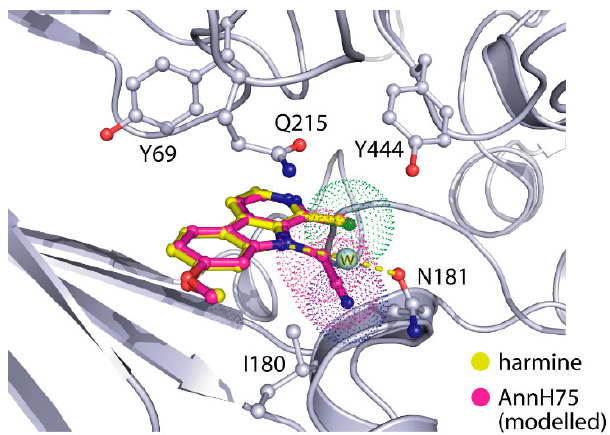
Figure 5. AnnH75 (magenta) docked into the harmine (yellow)-MAO-A structure (PDB 2ZGX).